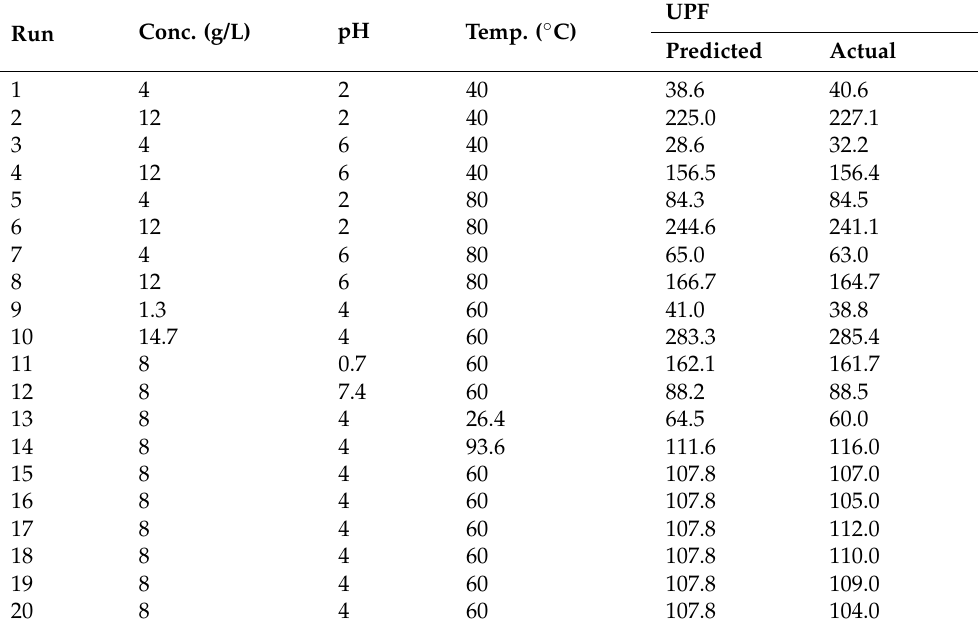
Table 2. Composition of various runs; predicted and actual